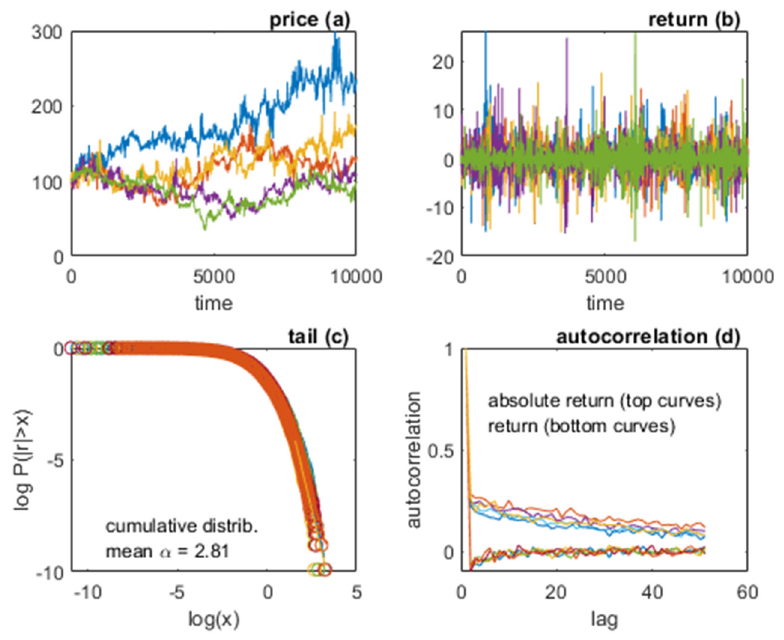
Figure 6. The general model: five simulations superposed. ( a ) price; ( b ) return; ( c ) tail; ( d ) autocorrelation function of return and absolute return.